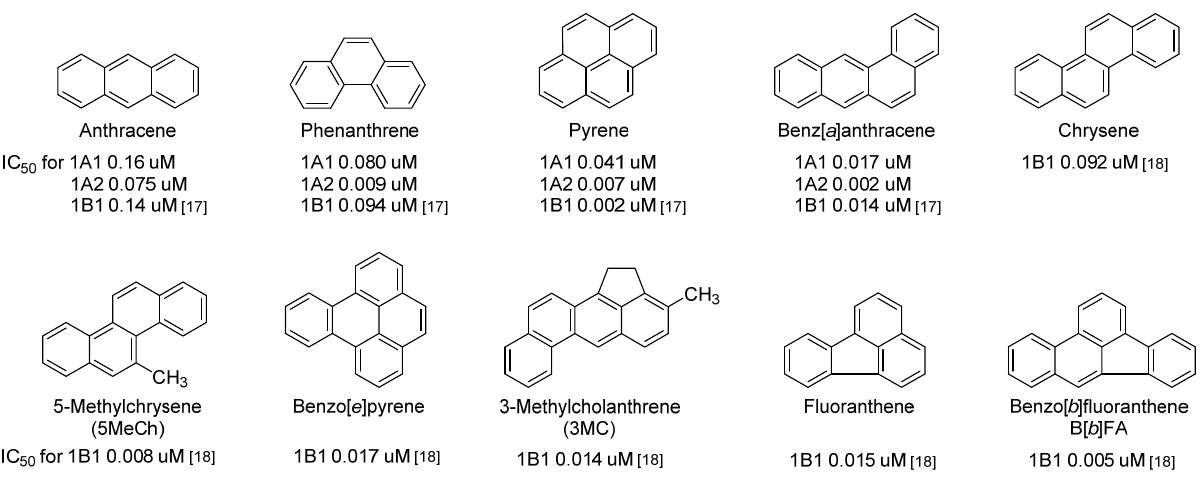
Figure 1. Polycyclic aromatic hydrocarbons as P450 family 1